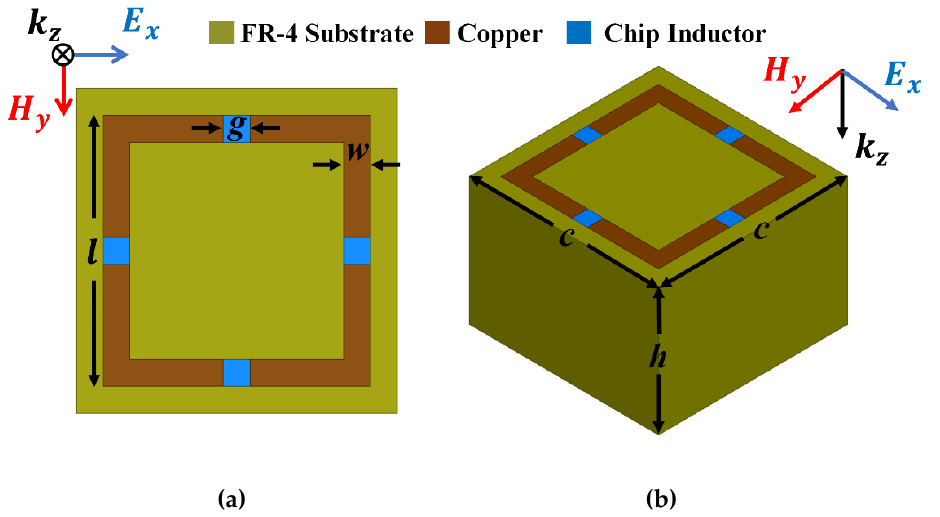
Figure 2. Proposed MM absorber unit cell: ( a ) top and ( b ) perspective view.